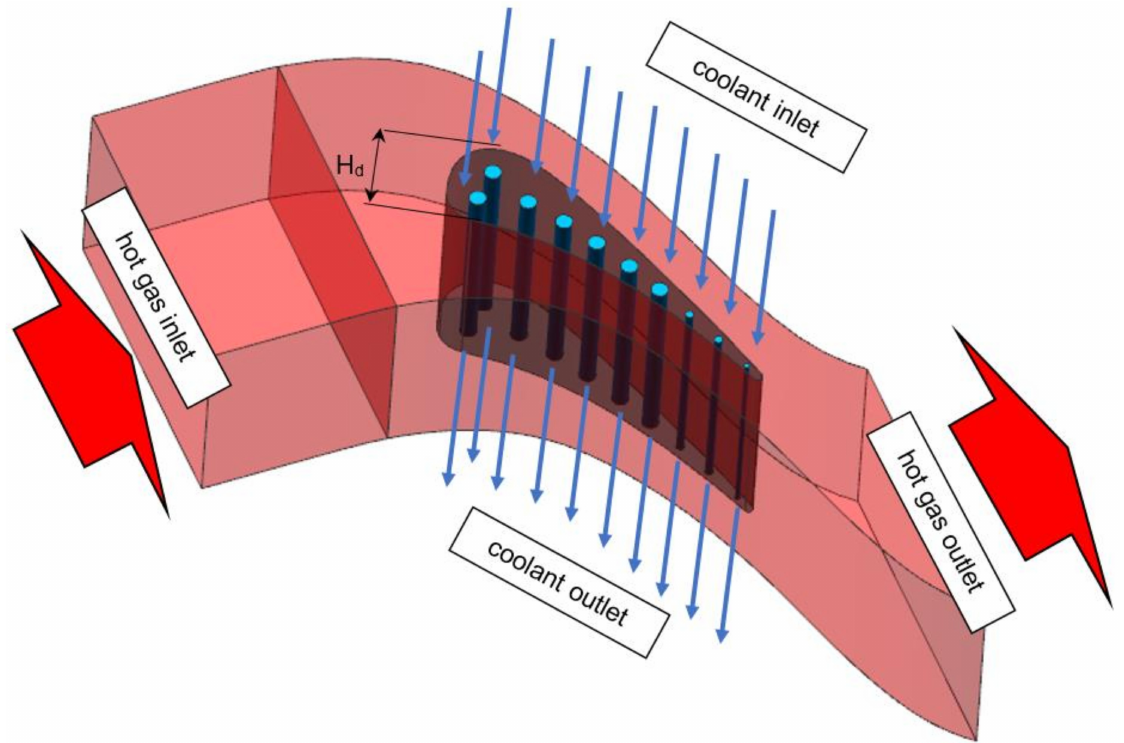
Figure 3. Geometry taken for analysis with flows’ directions (periodic boundary